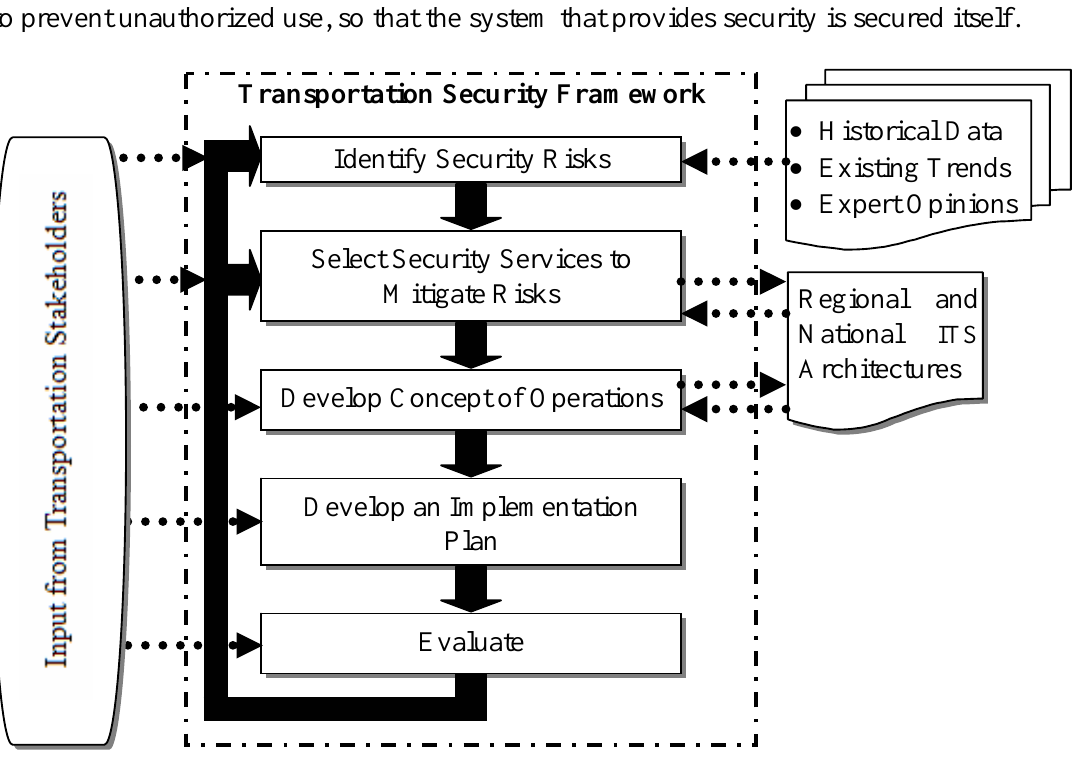
Figure 1. Process for developing a transportation security